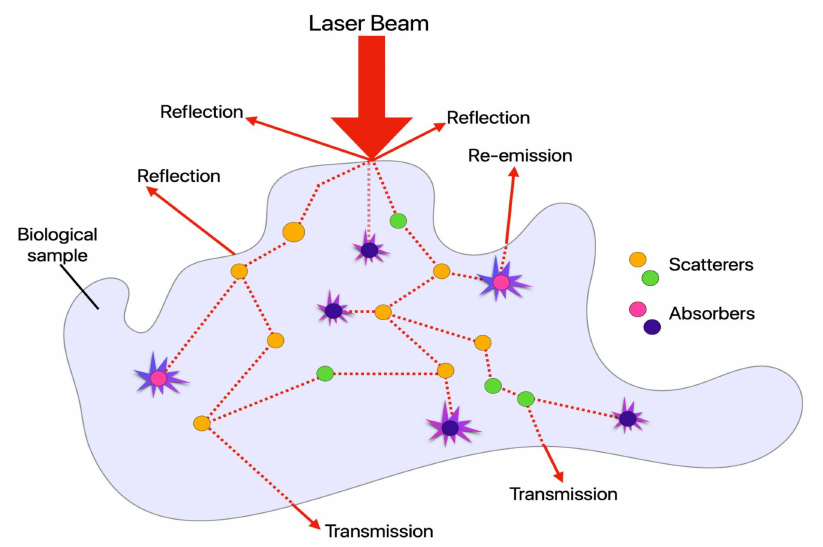
Figure 5. Primary effects of light–tissue interactions. Different components might act as scatterers or absorbers, depending on the wavelength of the incident light. Scatterers generate Raman signal, for example, while absorbers are endogenous or exogenous fluorophores as well as chromophores. Depending on the thickness of the sample (and the energy of the incident light), it might be possible to detect signal transmitted through the